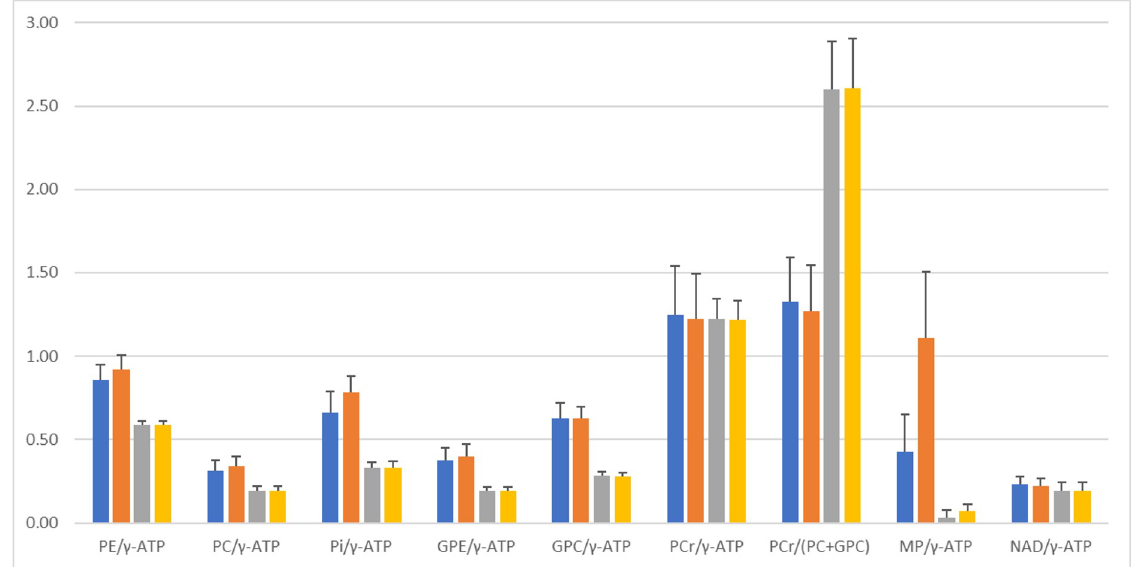
Fig 6. Comparison of [ 31 P metabolite]/[ γ -ATP] ratios measured at 3 Tesla and 7 Tesla. 3 Tesla spectra (TR = 25 seconds) and 7 Tesla spectra (TR = 30 seconds) were fitted with freely adjustable linewidths for MP. Blue: 3 Tesla, fitted using Gaussian lineshape; orange: 3 Tesla, fitted using Lorentzian lineshape; grey: 7 Tesla, fitted using Gaussian lineshape; yellow: 7 Tesla, fitted using Lorentzian lineshape.